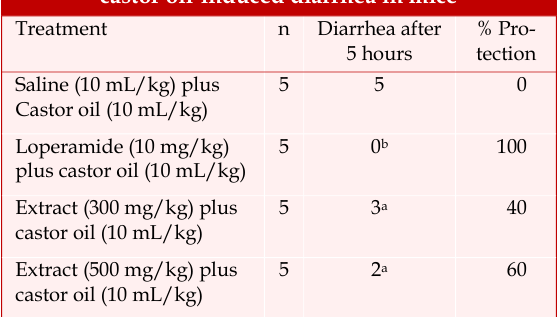
Antidiarrheal effect of A. capillus-veneris against castor oil-induced diarrhea in mice